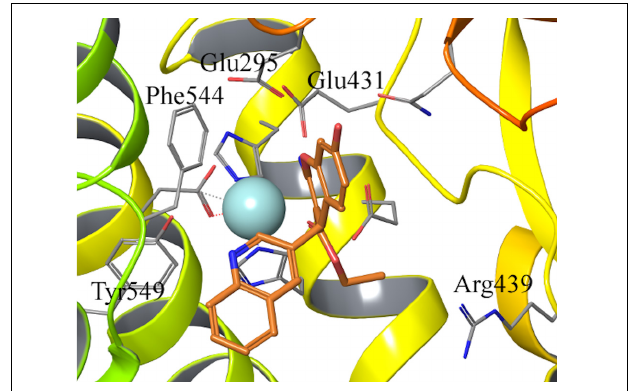
FIGURE 2 | Binding pose of compound 7 (orange sticks) in IRAP active site obtained from the constrained docking calculations. Key residues in the active site are shown as gray lines, and the Zn 2 + as light blue